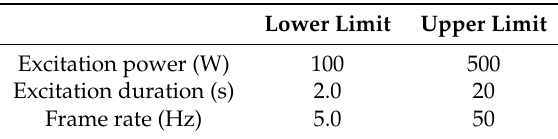
Table 3. Thermal optimization parameter